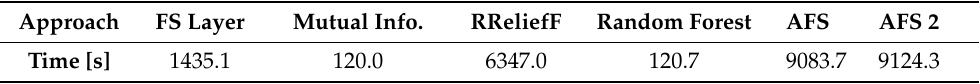
Table 15. Time duration for feature importance values generation (C-MAPSS FD004 case).